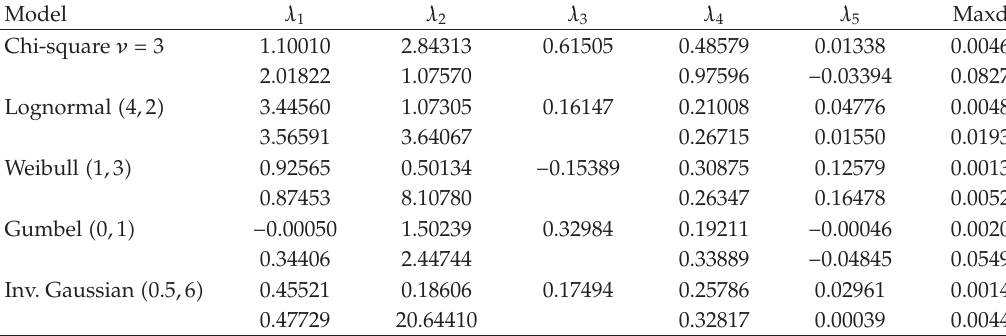
Table 2: Comparison of FPLD and GLD approximations for asymmetric